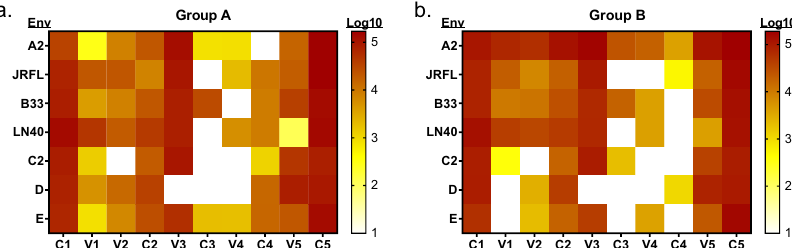
Fig. 3 JPT microarray analysis of IgG speci fi city in DP6-001 vaccinee sera (Group A and Group B, at 1:1000 dilution) against different regions of individual gp120 proteins. The heatmap indicates mean binding intensity from Group A (Panel a ) or Group B (Panel b ) against each gp120 region. The side bar indicates the levels of